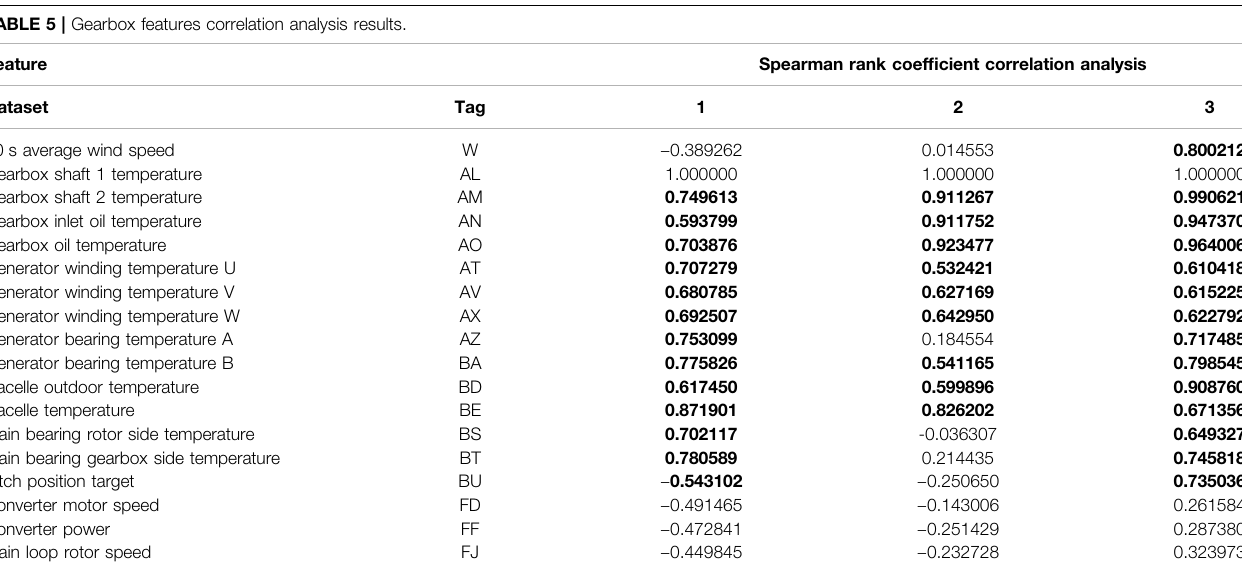
TABLE 5 | Gearbox features correlation analysis results.